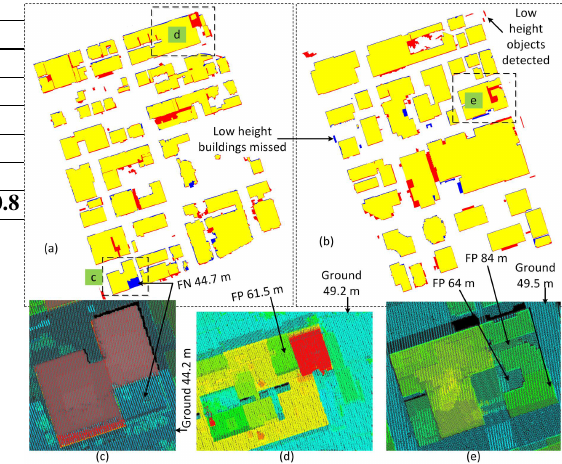
Figure 10: Building detection in the Toronto data set: (a) Area 4 and (b) Area 5. Some complex cases from (a) and (b) are shown in (c) to (e). Yellow = true positive, blue = false negative (FN) and red = false positive (FP)